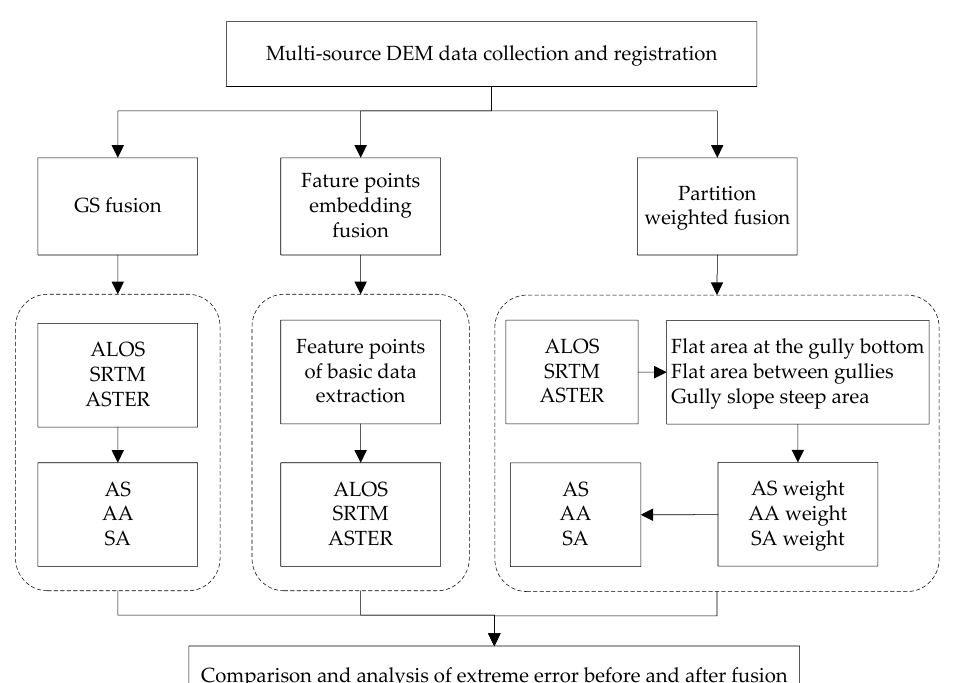
Figure 3. The flowchart of the research process.